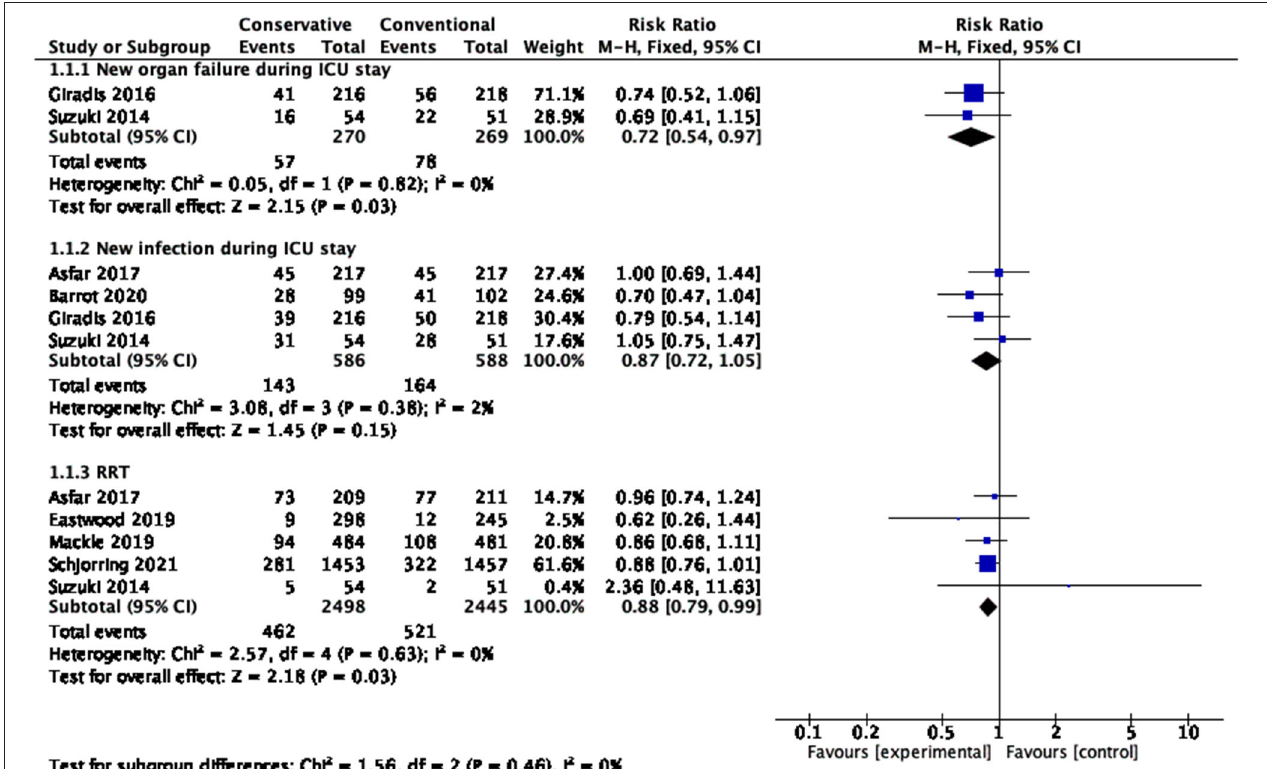
FIGURE 6 | New infection, new organ failure and rate of RRT during the ICU stay. CI, confidence interval; ICU, intensive care unit; RRT, renal replacement therapy; SD, standard